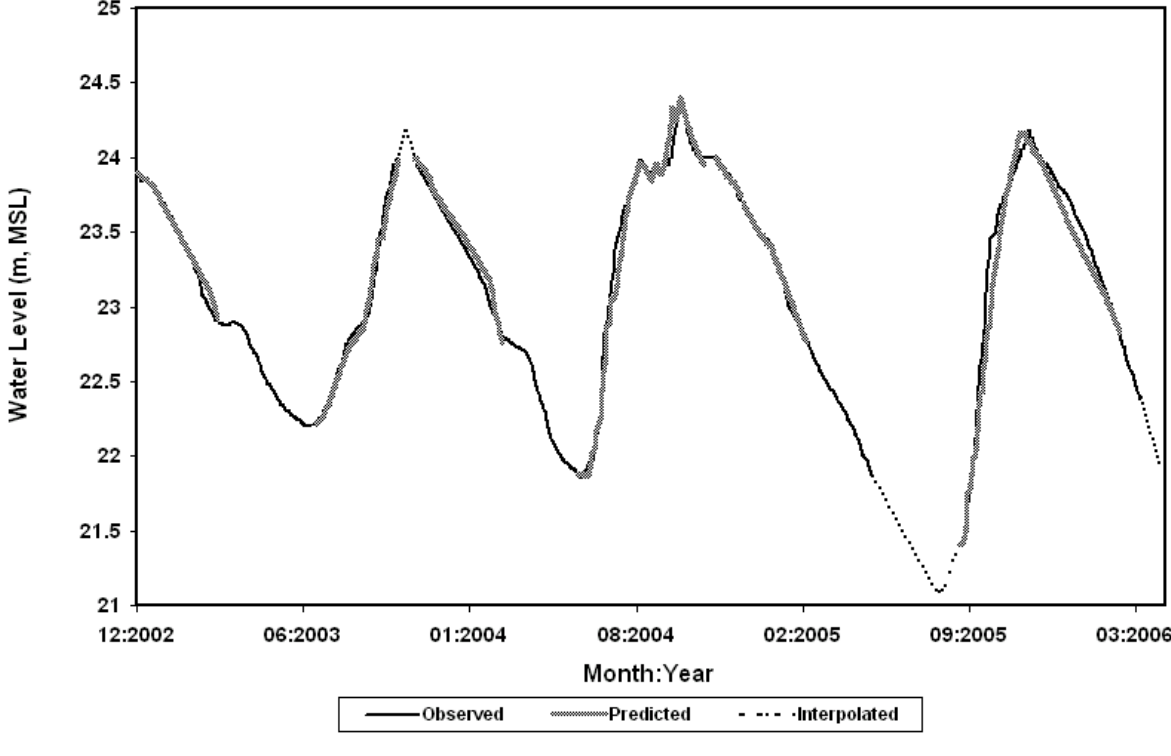
Figure 7. Observations of the reservoir stage height over the study period vs. predicted values. (Note: observed =observed level; predicted = predicted level for inflow and Outflow 1periods; interpolated data for unrecorded reservoir